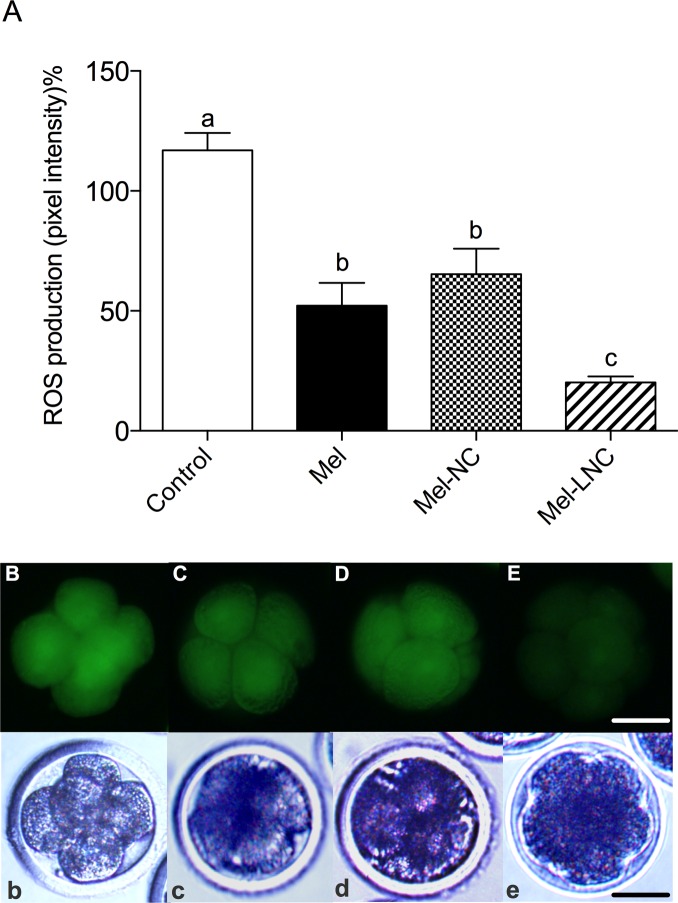
ROS levels in 4–8 cell stage embryos cultured in the presence of free and nanoencapsulated melatonin.Embryos were cultured in the presence of 10−9 M melatonin non-encapsulated (Mel) or encapsulated in nanocapsules (Mel-NC) or lipid-core nanocapsules (Mel-LNC). In the control group embryos were cultured in SOFaa BSA medium alone. Data represent mean ± S.E.M. Different letters above the error bars indicate significant differences between groups (P< 0.05). Representative fluorescent (B, C, D, E) and corresponding bright field (b, c, d, e) images of control, Mel, Mel-NC, and Mel-LNC embryos, respectively. Scale bar = 50 μm. Magnification = 100X.